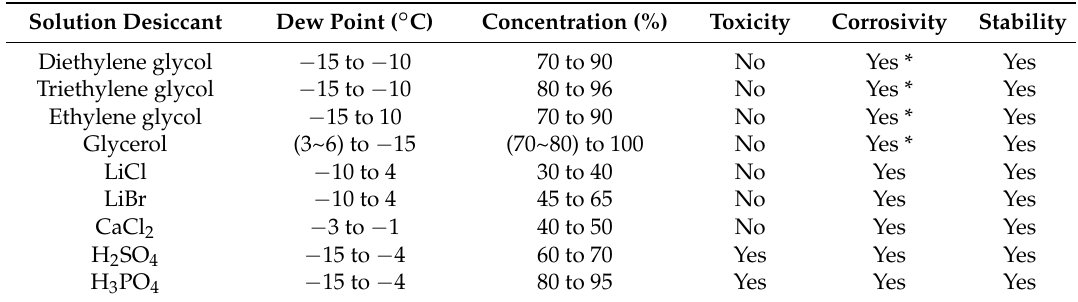
Table 8. The characteristics of common liquid desiccants